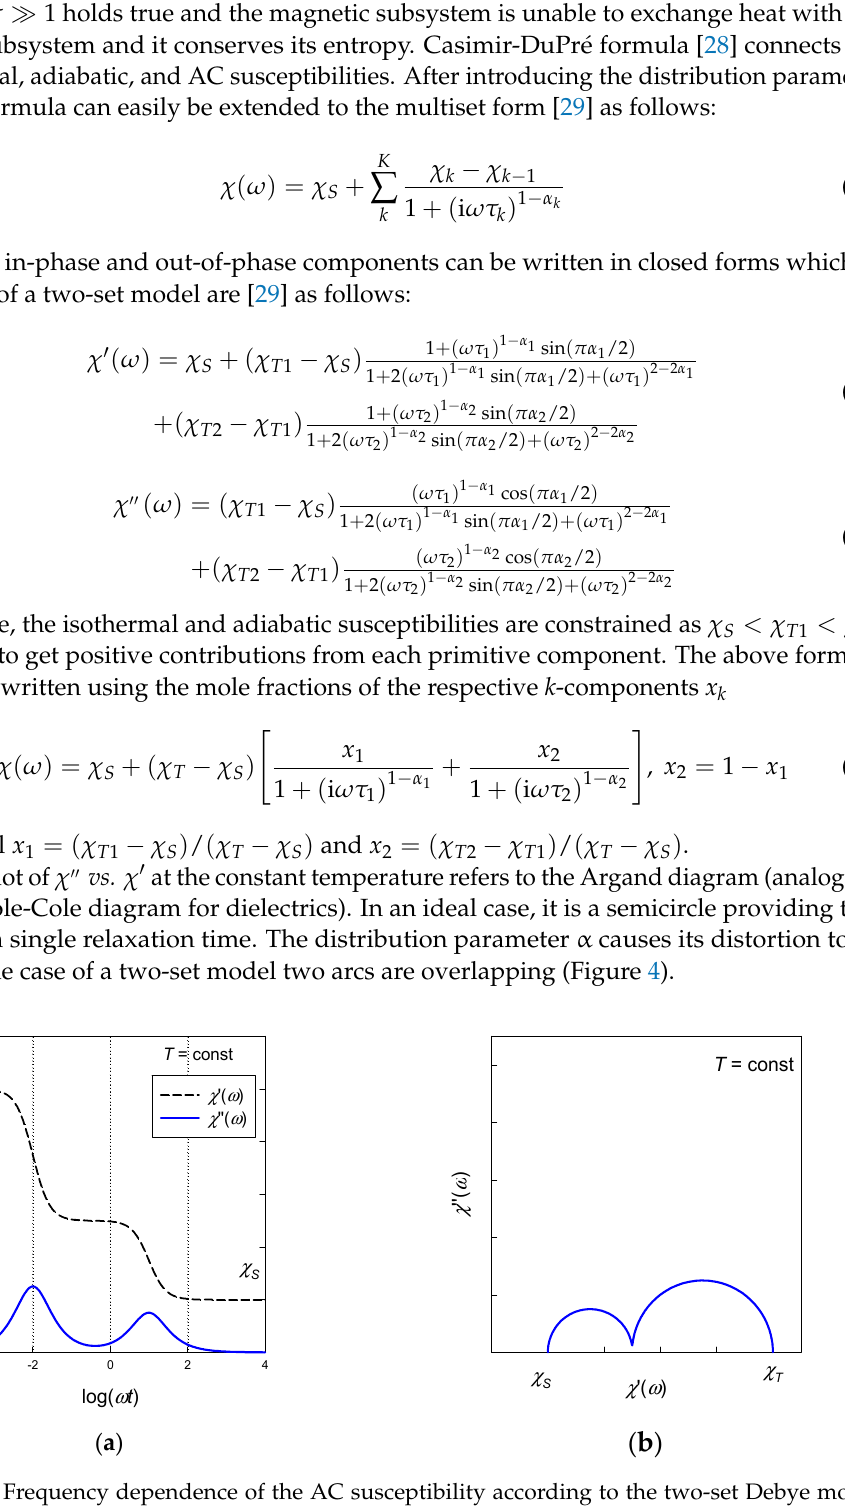
(18) The spin-orbit coupling involves the free-ion spin-orbit splitting parameter λ = – ξ /2 S , the orbital and spin Zeeman terms, and the axial (rhombic) crystal-field splitting parame- ter Δ ax ( Δ rh ). In addition, ξ is the spin-orbit coupling constant and the other symbols are in their usual meaning. The remaining parameters involve the orbital reduction factor κ , and the Figgis CI parameter A . Due to the T-p isomorphism the orbital angular momentum is L p = 1 and g L = − 1. This Hamiltonian can be treated by a numerical procedure. For Co(II),